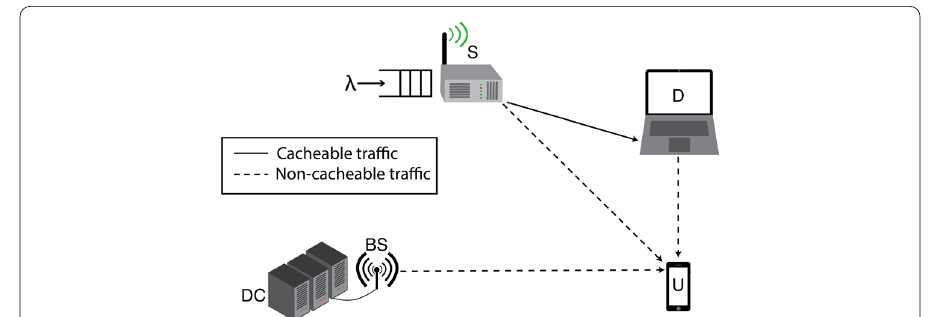
Fig. 1 An example of our system model. Caching helpers S and D can be access points with storage capabilities. Node S has a dedicated connected user D , who is randomly generating requests for non-cacheable content. At the same time, there is a mobile device U within both helpers’ proximity, which requests cached content from external resources with some probability in each time slot. Device U also has access to the data center DC through the BS , but the connection can be problematic, so it is preferred to be served by D or S , when possible. Please note that interference to the transmitters is not depicted